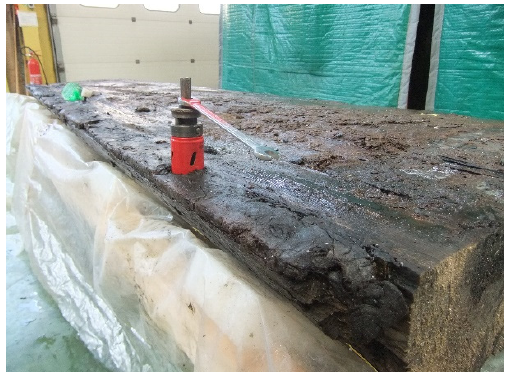
Figure 1. ( a ) Excavation site in Lyon; ( b ) the large pools containing the polyethylene glycol (PEG) drying; ( c ) drying process carried out inside the apparatus for large-scale lyophilization procedure.